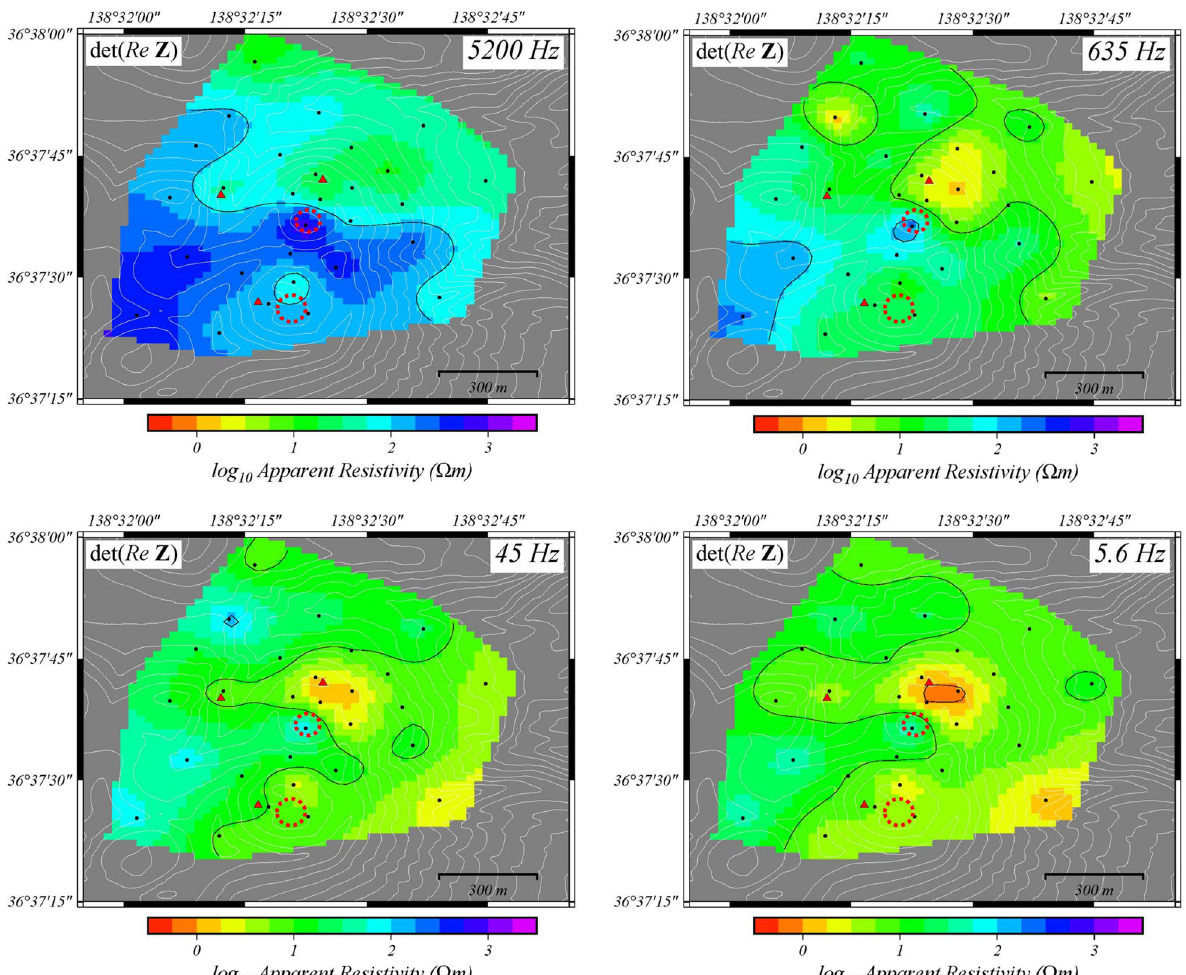
Fig. 3 Apparent resistivity distributions calculated using the rotational invariant det ( Re Z ) (the determinant of the real part of impedance Z ) for four representative frequencies (5200, 635, 45, and 5.6 Hz). Black dots show the AMT sites. The three red triangles represent the craters of the 2018 eruption (MC, WC, and SC in Fig. 2). Red dotted circles represent the Kagamiike-kita Crater and the Kagamiike